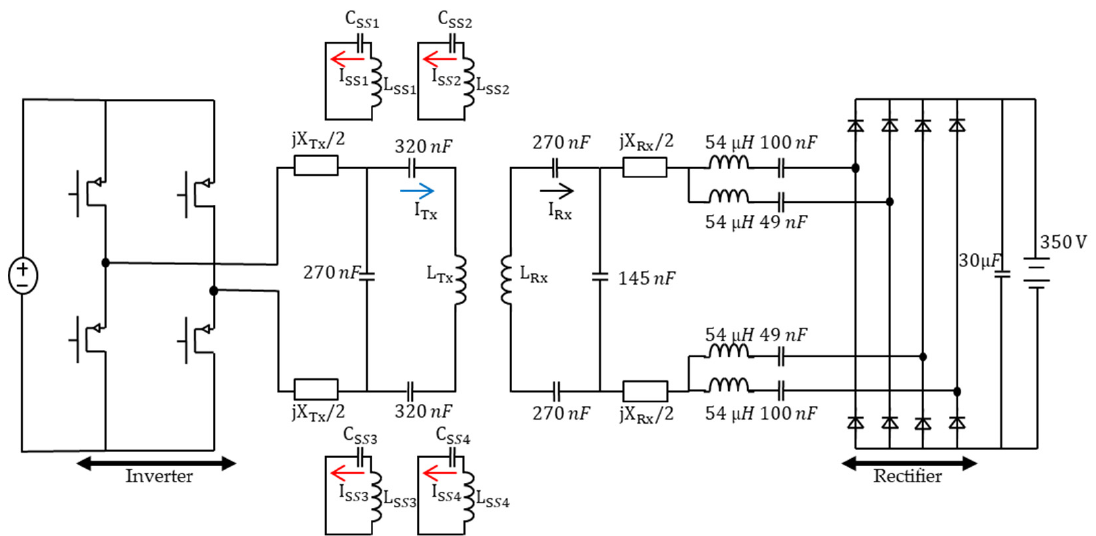
Figure 11. SAE J2954 WPT3/Z2 simulation circuit to which SS coils are applied. Table 3. Electrical parameters of the circuit.